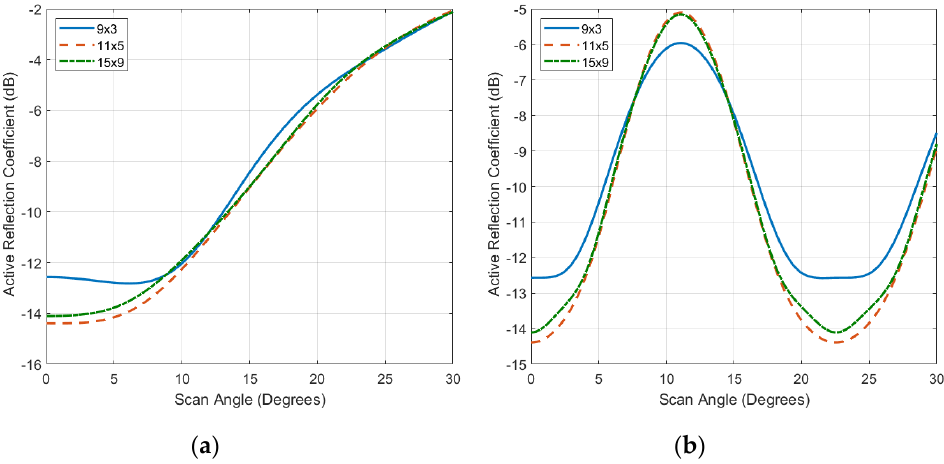
Figure 6. Active reflection coefficient versus scan angle θ 0 of the central element for ( a ) φ = 0° and ( b ) φ = 90° at the design frequency f 0 = 28.0 GHz.